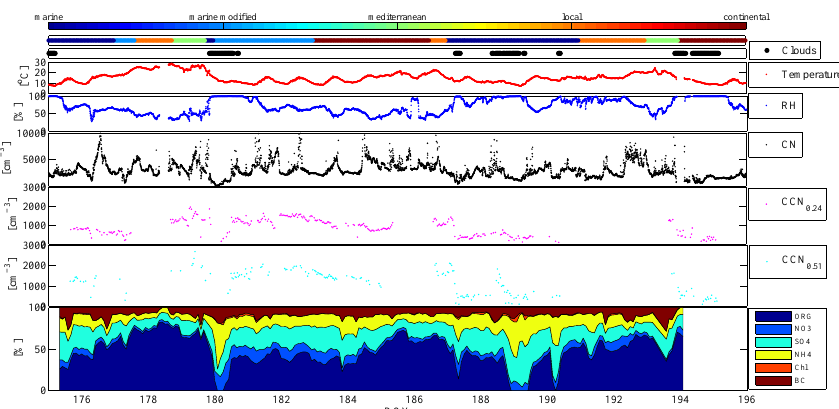
Fig. 2. Overview of conditions during the summer campaign. On panels, from top to down, are shown: air mass type, station inside cloud periods, temperature, relative humidity, total number concentration, CCN number concentration (at 0.24 and 0.51% supersaturations) and AMS volume fractions.